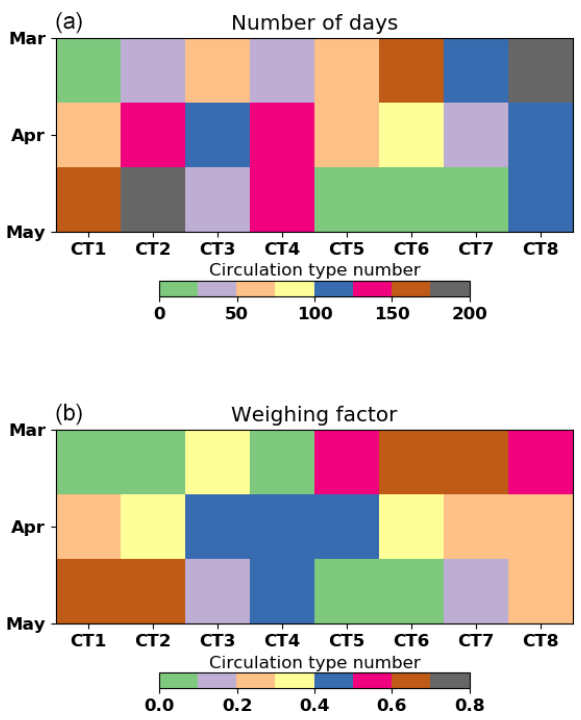
Figure 1. The number of days analyzed for each circulation type and month (a) and the corresponding weighing factor used to com- pute the climatologies of trace gases and aerosols (b)